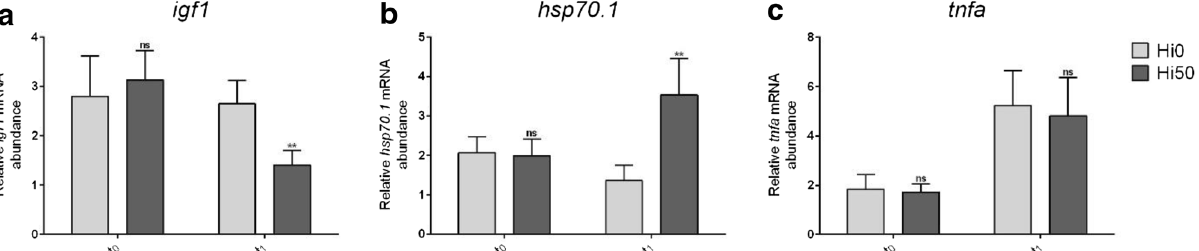
Figure 7. Relative mRNA abundance of genes analysed at t 0 and t 1 in Siberian sturgeon. ( a ) igf1 and ( b ) hsp70.1 were analysed in liver samples; ( c ) tnfa was analysed in intestine samples. Fish fed diets including 0 and 50 of BSF meal (Hi0 and Hi50, respectively). Significant differences between Hi0 and Hi50, compared within the same sampling time, are indicated as follows: ns non-significant; *p < 0.05; **p < 0.01; ***p < 0.001 and ****p < 0.0001. Values are shown as mean ± SD (n =